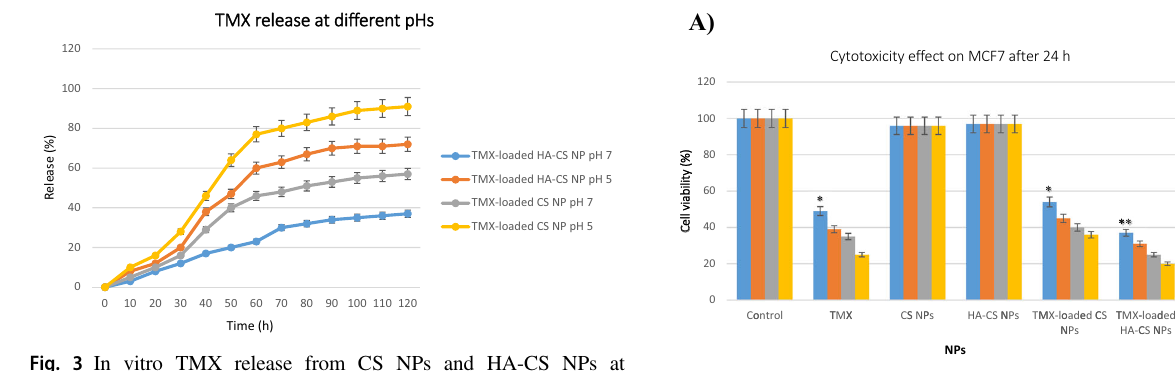
Fig. 3 In vitro TMX release from CS NPs and HA-CS NPs at different pHs